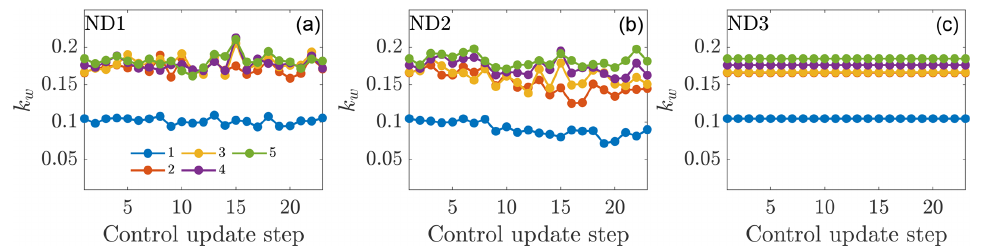
Figure 12. Wake spreading coefficient for each turbine in the wind farm for (a) online control using the initial parameters to initialize the next state (ND1), (b) online control using the previous optimal parameters to initialize the next state (ND2), and (c) the static state estimation control (ND3).